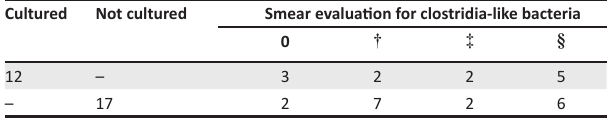
TABLE 2: A comparison of Clostridium perfringens isolation to the presence of clostridial-like bacteria on the smears of the ileal mucosa from the pigs in this study.